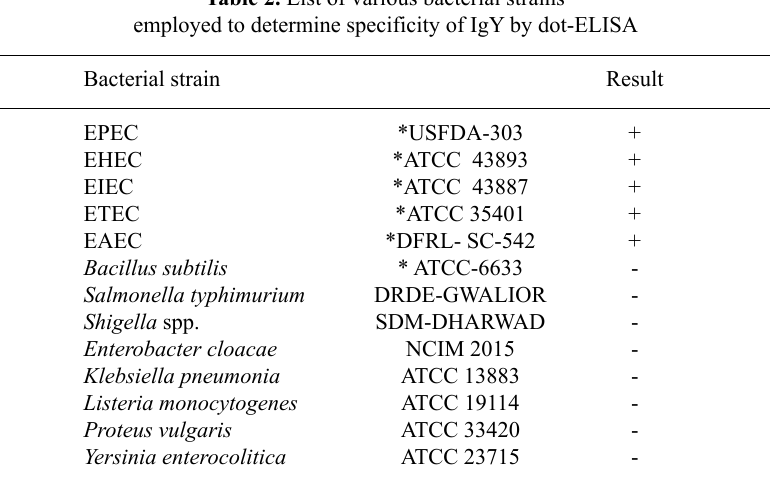
table 3. List of various bacterial strains employed to determine specificity by IC-PCR assay Bacterial